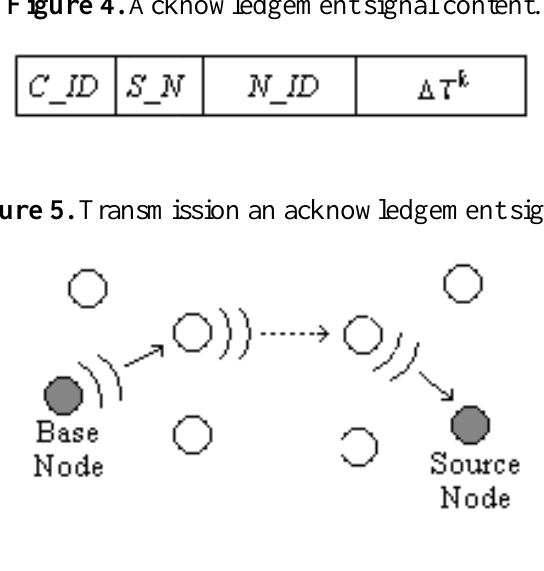
Figure 4. Acknowledgement signal content.